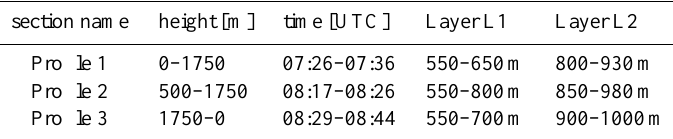
Fig. 1. Evolution of the boundary layer and lofted aerosol layers on 13 May 2008, from 07:15–09:45UTC in terms of the range-corrected 1064nm lidar signal. The vertical resolution is 7.5m and the temporal resolution 10s. Lidar signals are not trustworthy below 150m because of the incomplete transmitter-receiver overlap. The ACTOS-flight pattern is marked by the green line, the profiles and horizontal legs are labeled accordingly. L1 and L2 indicate layers with significantly increased particle number concentrations (discussed later in more detail). Table 1. Main characteristics of vertical profiles and height of the two layers L1 and